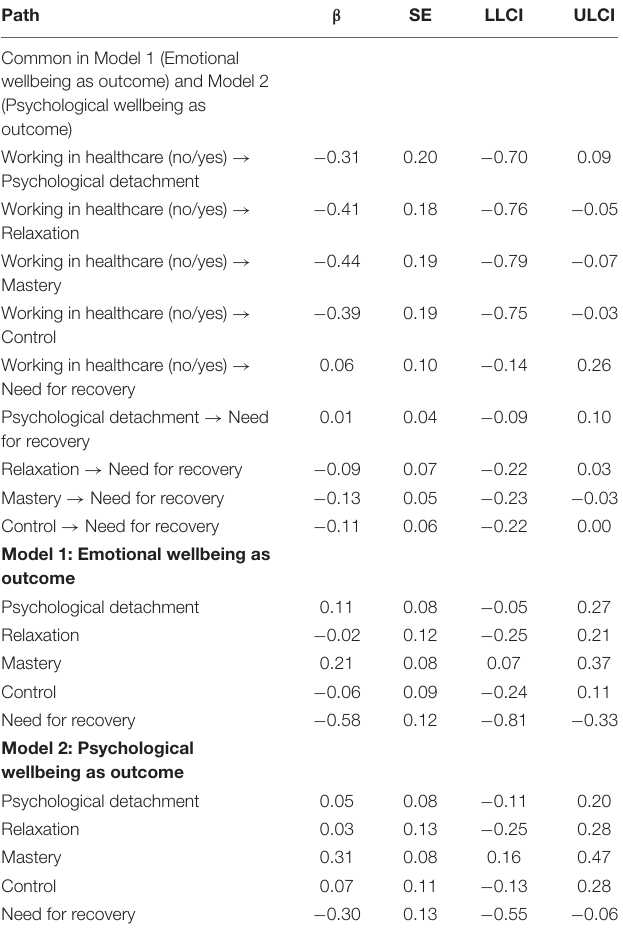
TABLE 2 | Results of the main effect analysis ( N = 217).